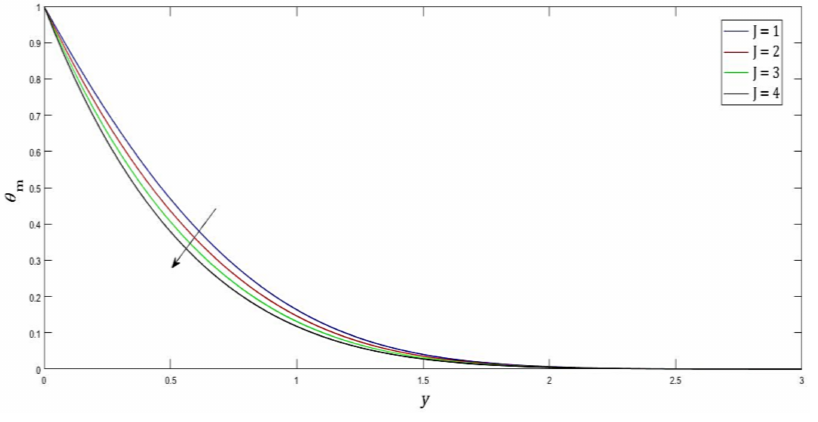
Figure 6. Variation in temperature profile with respect to heat absorption parameter.